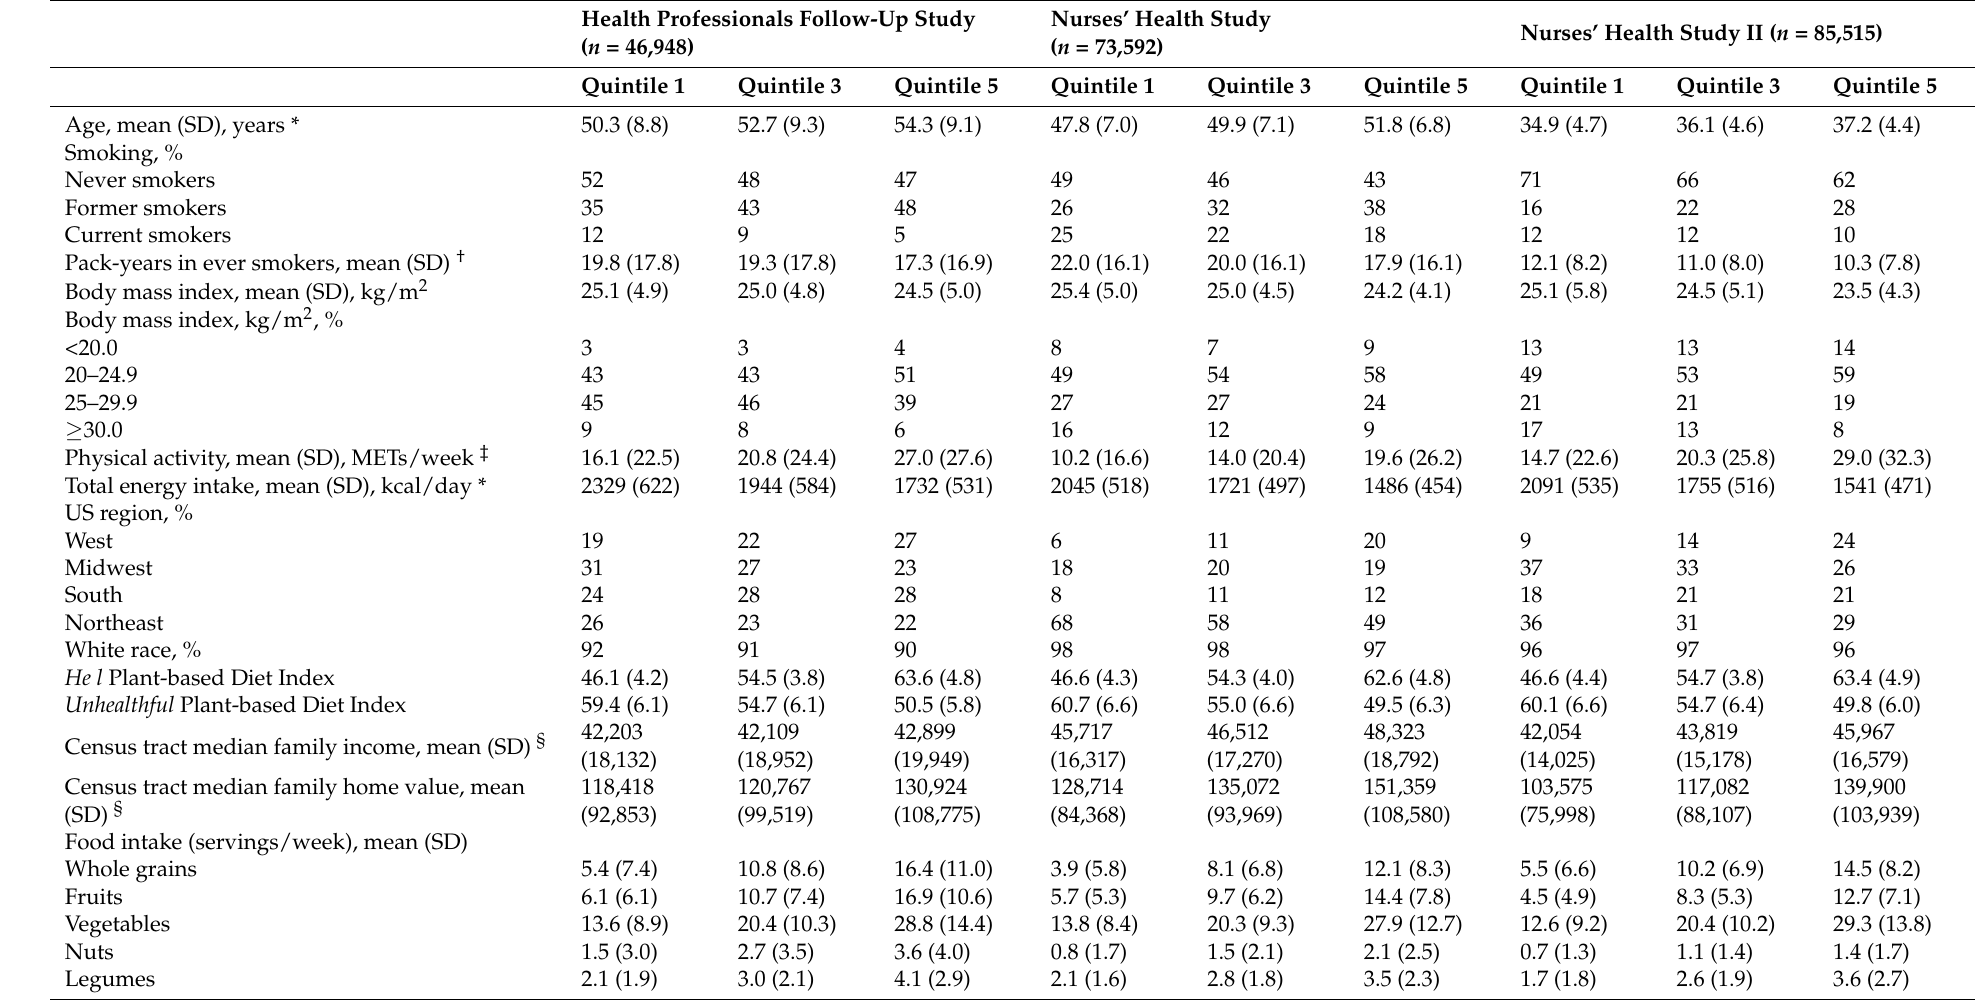
Table 1. Baseline characteristics in participants according to quintiles of healthful Plant-based Diet Index